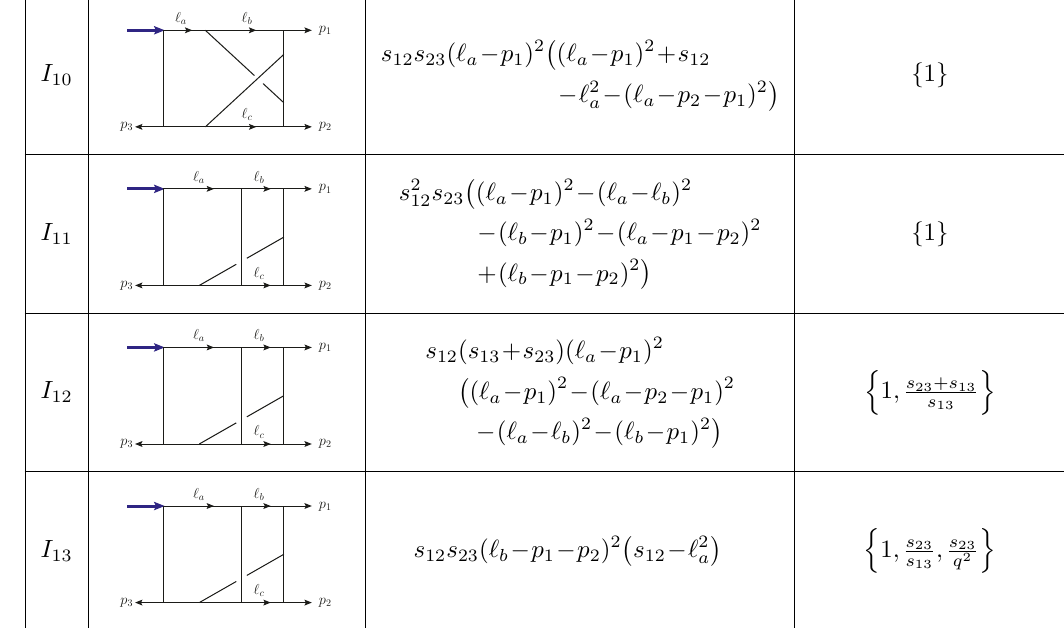
Table 6. d log integrals for non-planar tr( φ 2 ) form